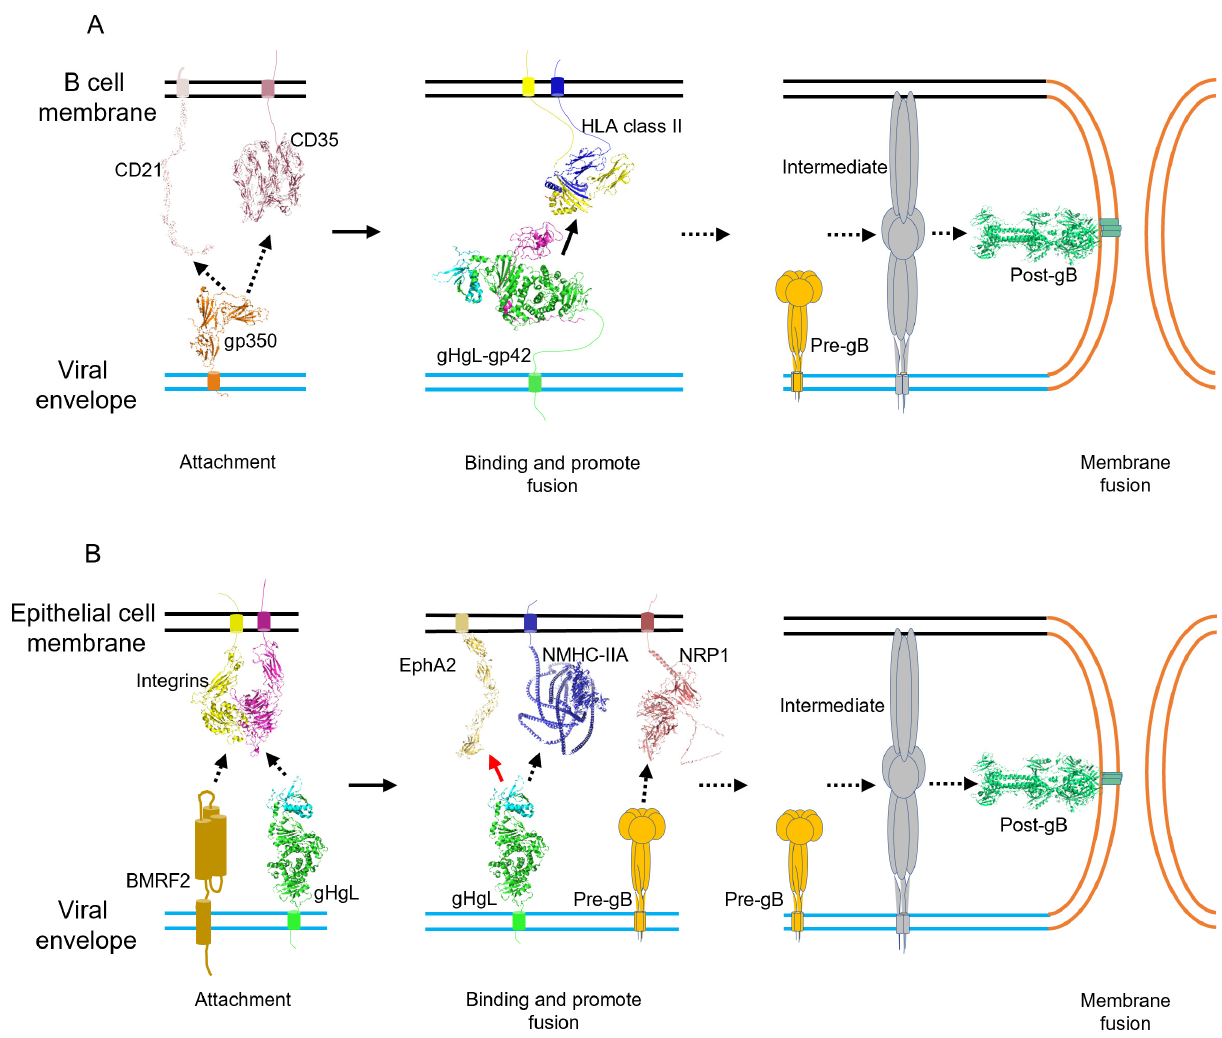
Figure 2. The process of EBV entry into host cells. ( A ) Entry of EBV into B cells through endocytosis. Firstly, EBV gp350 attachment with CD21 or CD35, and tethering EBV to B-cell membranes. Then, gH/gL-gp42 binds to receptor HLA class II. This interaction lets gH/gL-gp42 enable interacting with the prefusion form of gB. The interaction leads to a series of structural changes in gB and ultimately fusion of the viral membrane with the cell membrane. Extended rearrangements within gB (intermediate) enables insertion of the fusion loops into the B-cell membrane and the refolding of gB forms post-fusion gB, which mediates the merging of the two membranes. ( B ) The entry of EBV via direct fusion with epithelial cell membranes. Firstly, gp350/220 interacts with CD21 and/or BMRF2/gH/gL, with integrins tethering EBV to the epithelial cell membrane. After this, gH/gL binds to EphA2/NMHC-IIA or gB interacts with NRP1, producing a membrane fusion signal. The signal is passed to gB and causes a series of changes in its configuration. Extended rearrangements within gB trigger insertion of the fusion loops into the epithelial cell membrane, followed by the refolding of gB to post-fusion form and mediates the merging of the two bilayers. The structures are shown as cartoons: structures of CD21 (2GSX) [97], EBV gp350 (2H6O) [95], the complex of gH/gL (3PHF) [103], the complex of gp42-HLA-DR1 (1KG0) [101], post-fusion gB (3FVC) [98], and EphA2 (2X10) [104] and modified using the PyMOL Molecular Graphics System, Version 2.1.0 Schrödinger, LLC. The structure of integrin alpha5beta1 (3VI4) [105] was used as a representative model of integrins interacting with EBV membrane proteins. The structure files were retrieved from the PDB database. The structure of NMHC-IIA, NRP1, and full-length CD35 are generated by AlphaFold Protein Structure Database